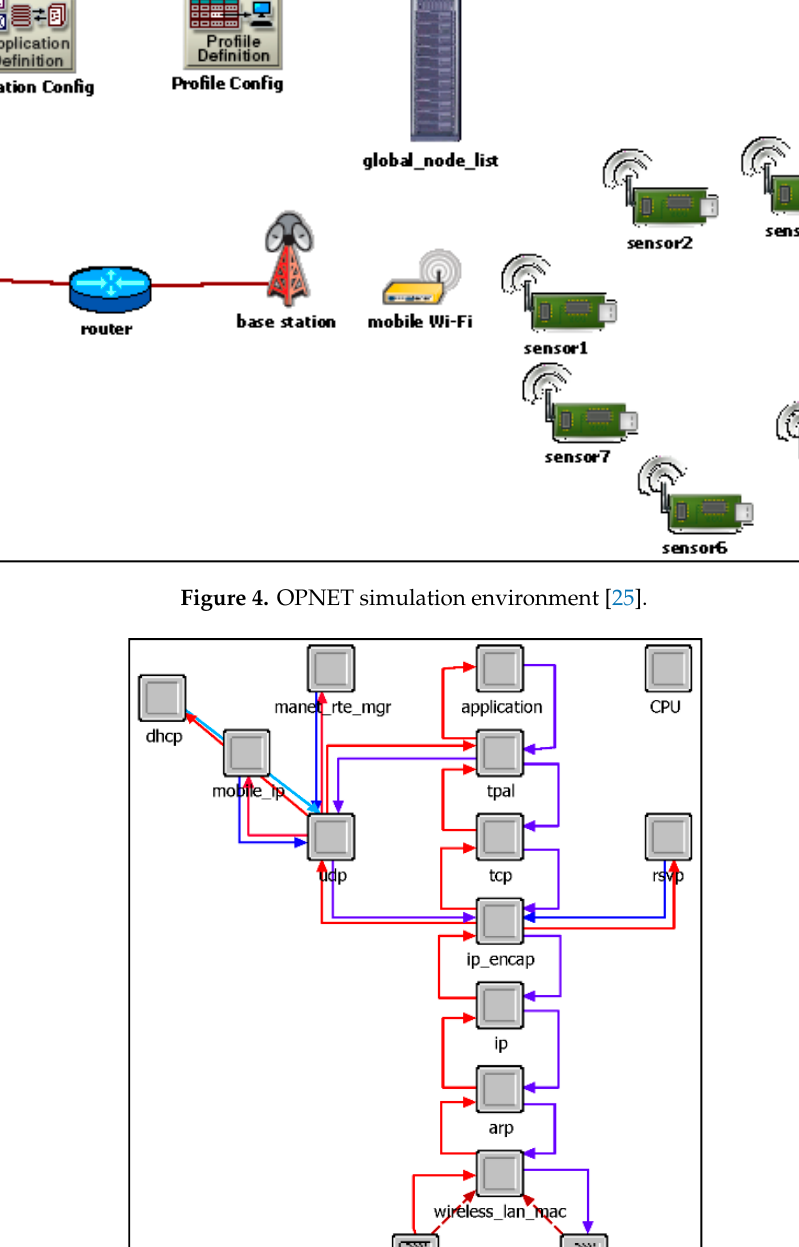
Figure 5. OPNET node model with protocol stack for sensor nodes .